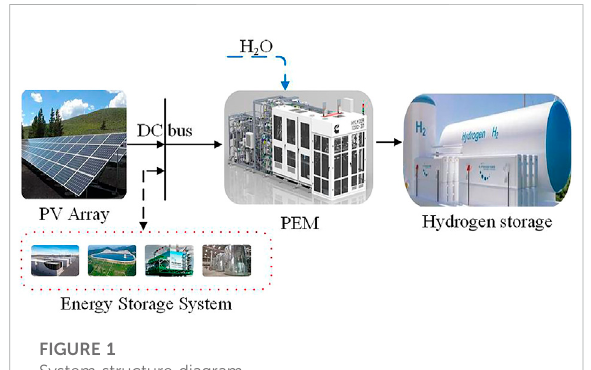
FIGURE 1 System structure diagram.